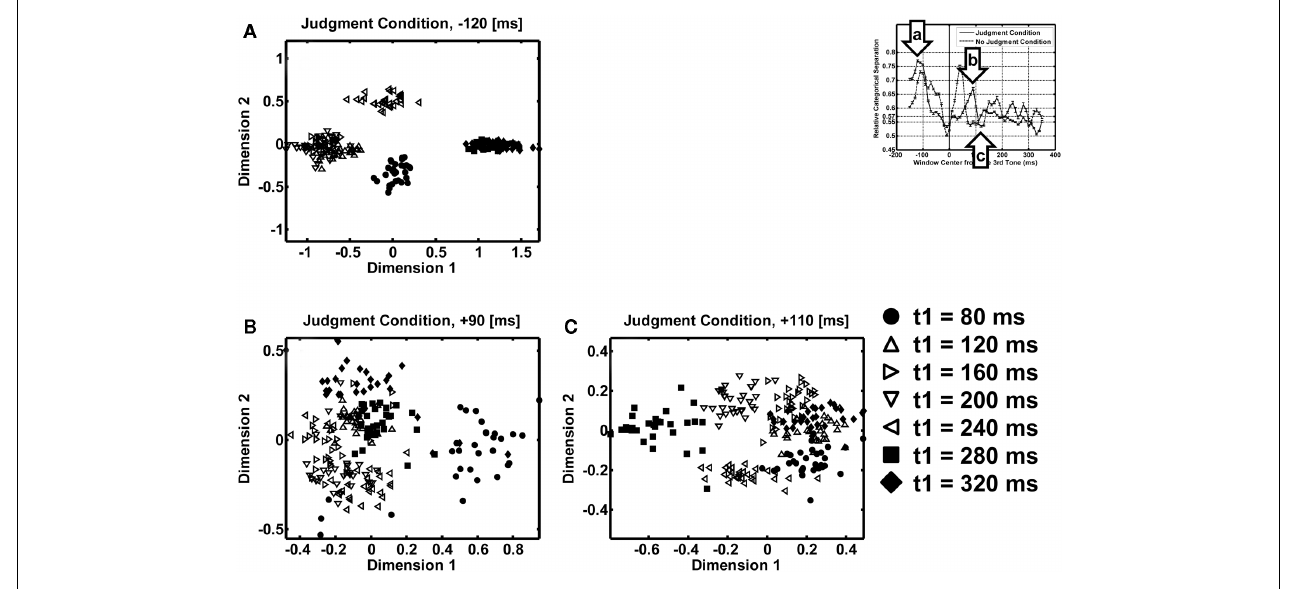
of relative categorical separation. Different symbols represent different temporal patterns. Filled symbols represent perceptually unequal temporal patterns. Open symbols represent perceptually equal temporal patterns.The scatter of a symbol shows the variability across different resampling in bootstrapping ( N = 30).